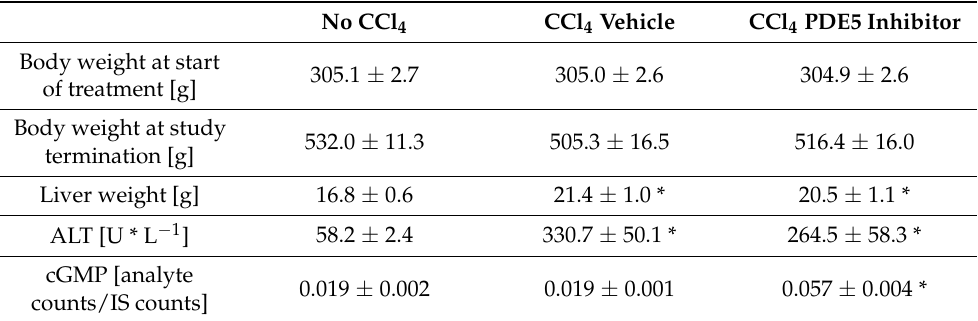
Table 1. Body weights, liver weights and plasma aminotransferase (ALT) and cGMP level in control, CCl 4 /Vehicle and CCl 4 /PDE 5 inhibitor treated